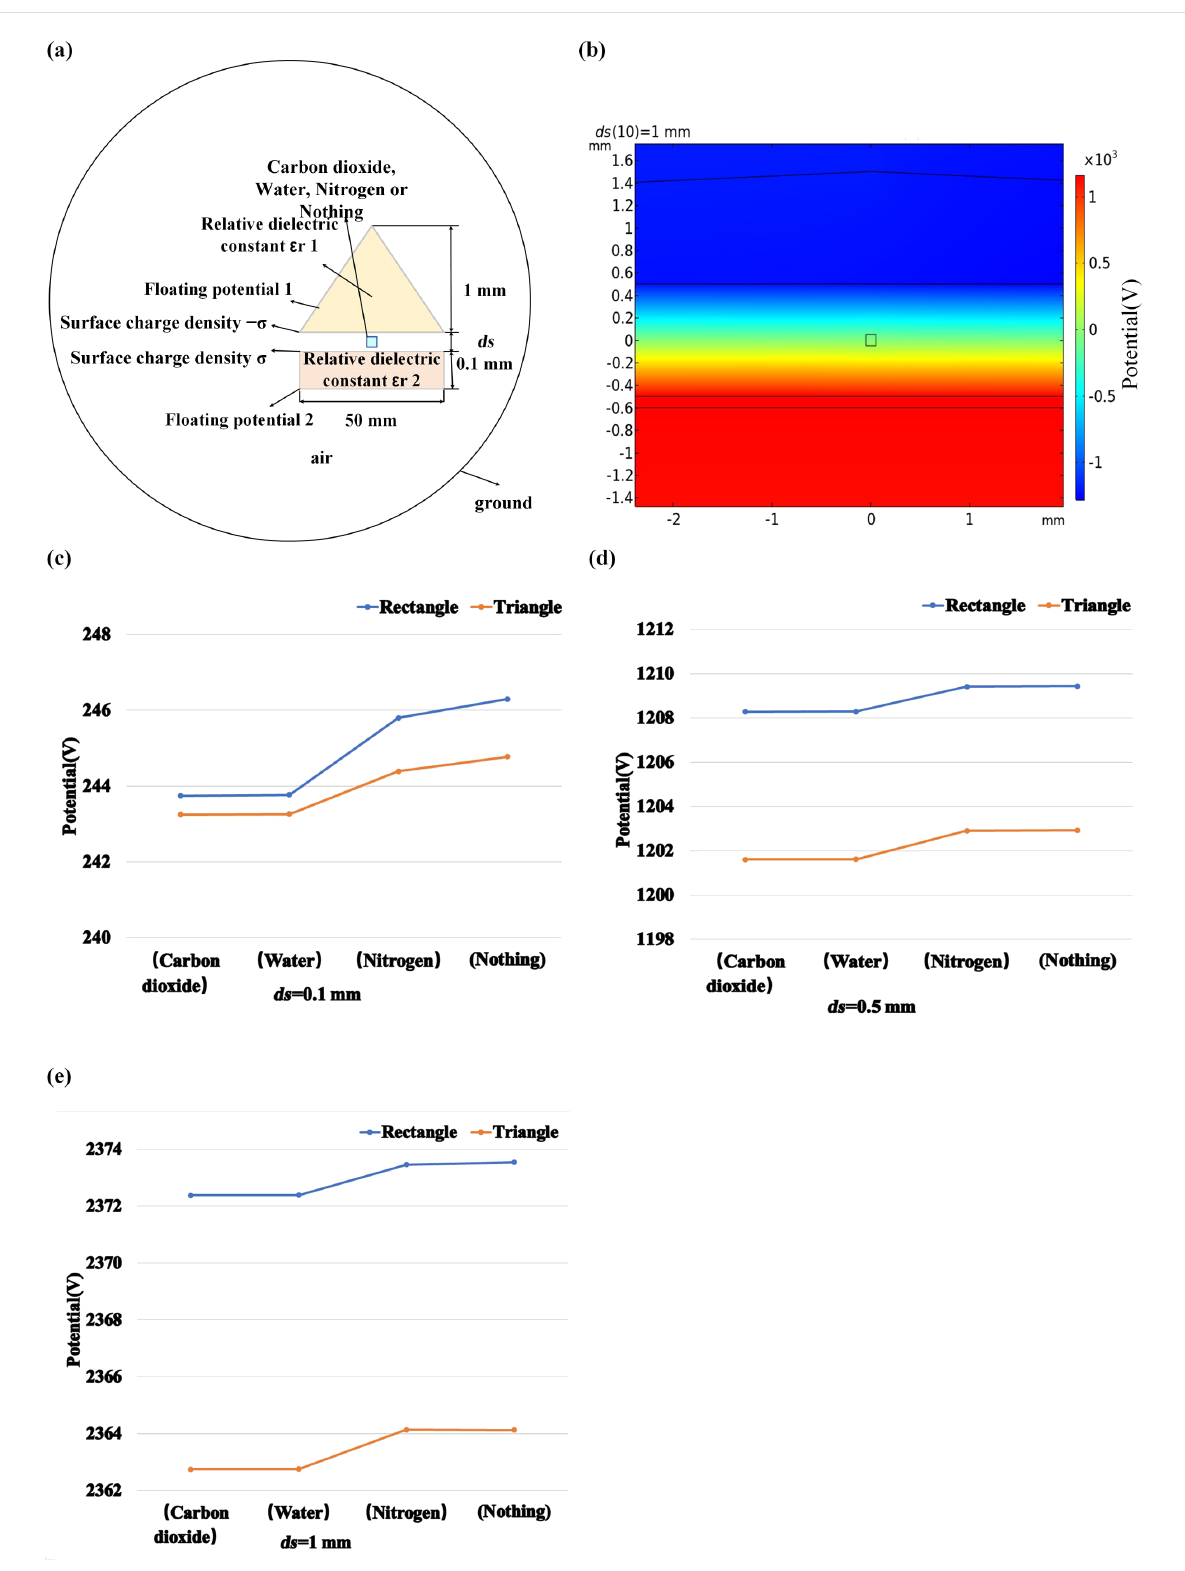
Figure 9: (a) Schematic diagram of an isosceles triangle TENG with injected gases. (b) Simulation of the TENG potential. (c–e) Potential diagram of the two shapes of TENGs with different injected gases at the same distance ds